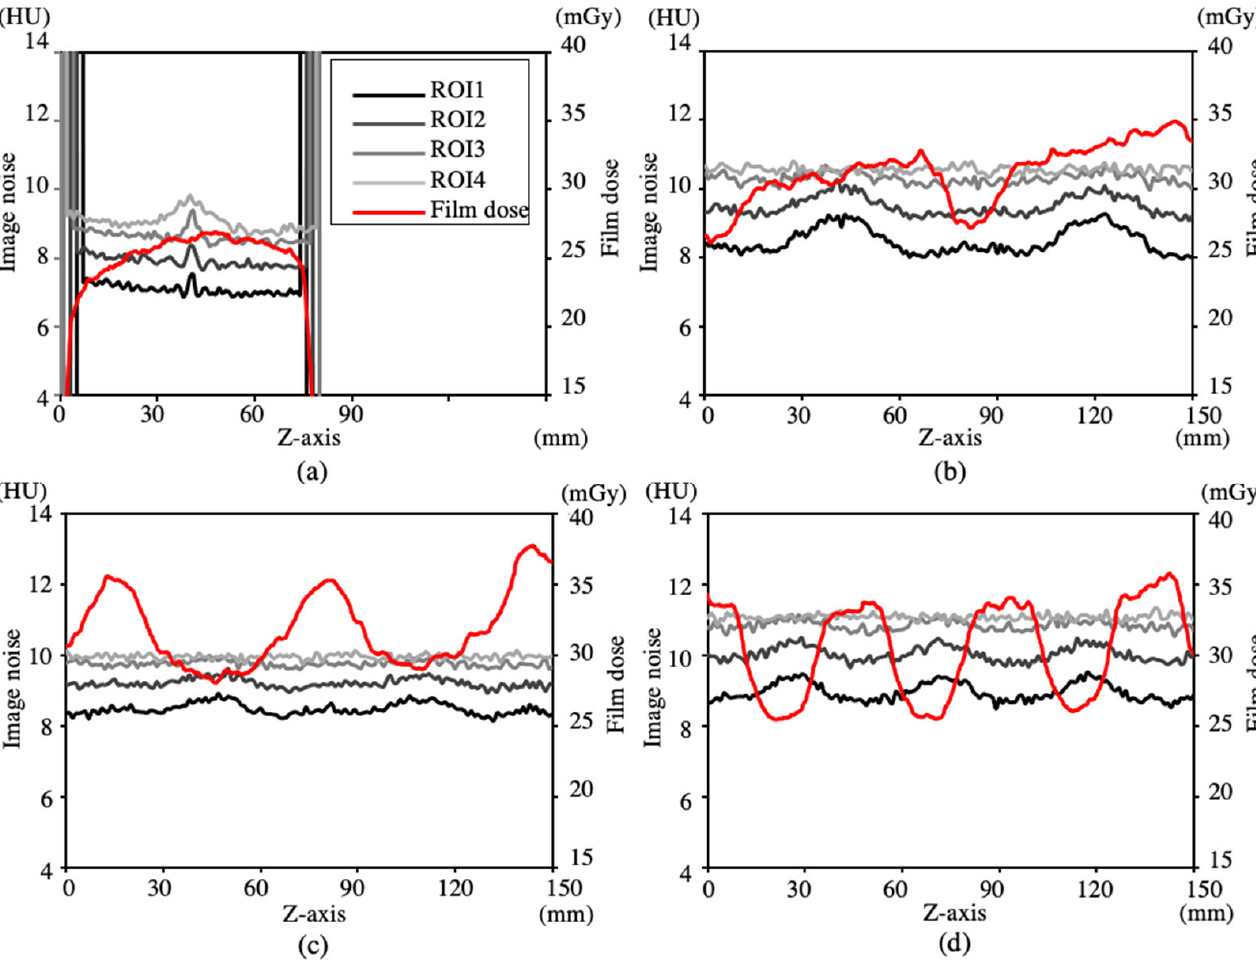
Figure A1. ROI2, ROI3, and ROI4 in 256-slice CT. ( a ) Axial scan. Helical scans with pitch values of ( b ) 0.992, ( c ) 0.696, and ( d ) 0.399.